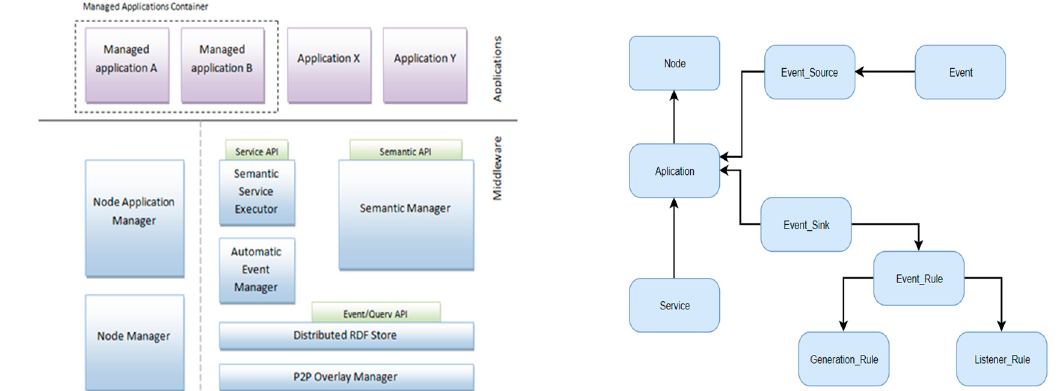
Figure 4. Semantic routing system and middleware ontology.